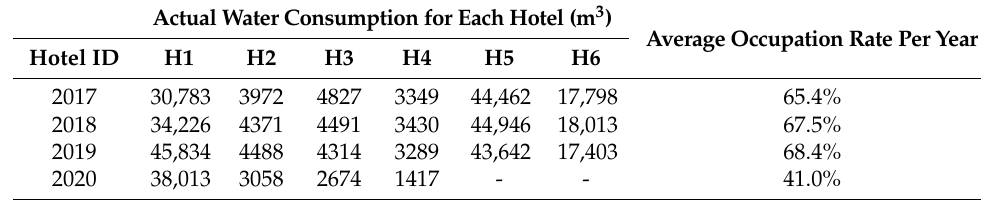
Table 17. Hotels’ water consumption during the later years and average occupation rate. Actual Water Consumption for Each Hotel (m 3 )